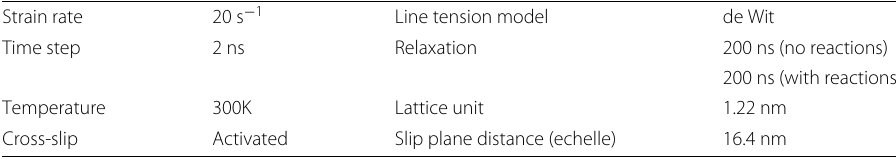
Table 2 Discrete dislocation dynamics parameters